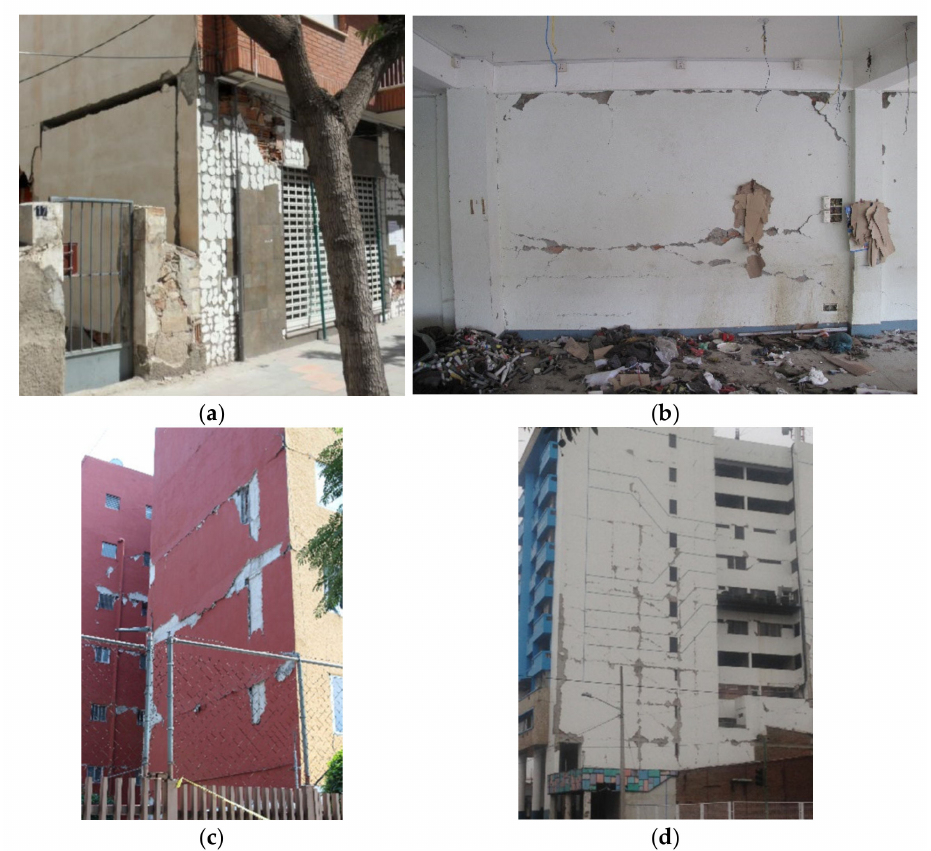
Figure 19. Damage type 10—damage in infill panels: detachment of the panel from the envelope frame: ( a ) Lorca, Spain 2011; ( b ) Gorkha, Nepal, 2015; ( c ) Chiapas, Mexico, 2017 and ( d ) Muisne, Ecuador,